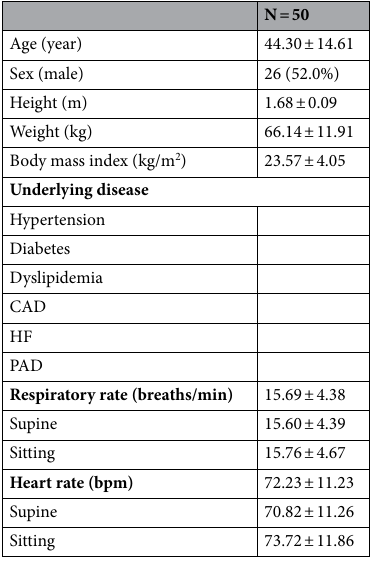
Table 1. Baseline characteristics of the participants. Data are described as the mean ± SD or N